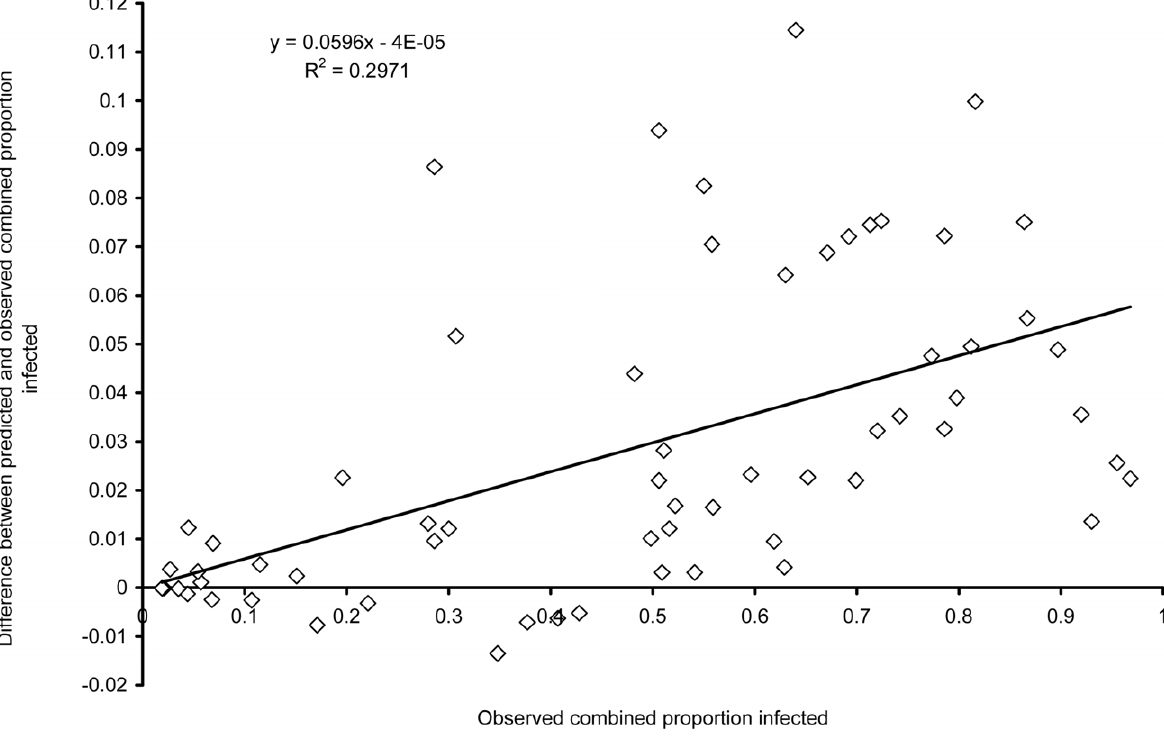
Figure 3. A scatter plot of the observed combined proportion infected with intestinal nematode worms and the difference between the predicted and observed proportion infected.